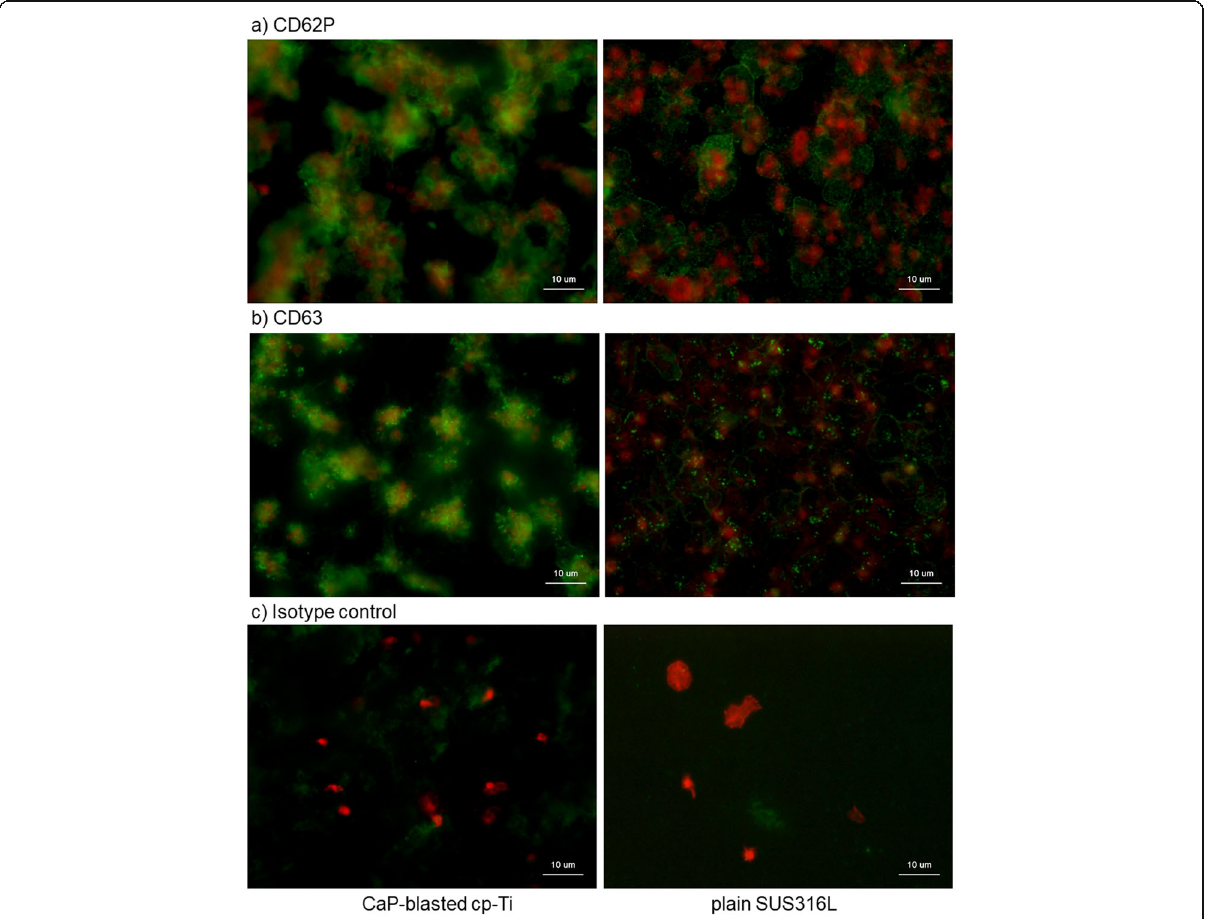
Fig. 9 Immunocytochemical detection of activated platelets expressing a CD62P or b CD63. CaP-blasted cp-Ti and plain SUS316L plates were incubated with PRP for 60 min, washed, fixed, and subjected to immunocytochemical visualization. Green represents proteins reactive for a CD62P or b CD63, while red represents polymerized actin. c To show non-specific detection in extra-platelet spaces, PRP containing relatively low platelet counts was added on the plates and